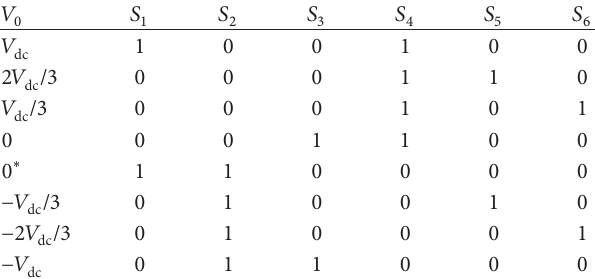
Table 3: Switching pattern for the single-phase seven-level